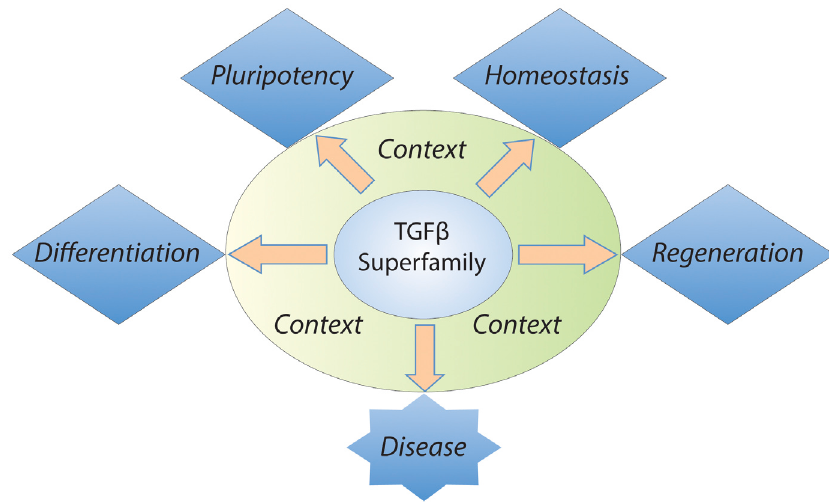
Figure 1. Context-dependent transforming growth factor β ( TGF β ) superfamily signaling. Diverse biological activities regulated by TGF β pathways are rigorously controlled in a finely calibrated contextual framework. Perturbation in these processes can lead to disease